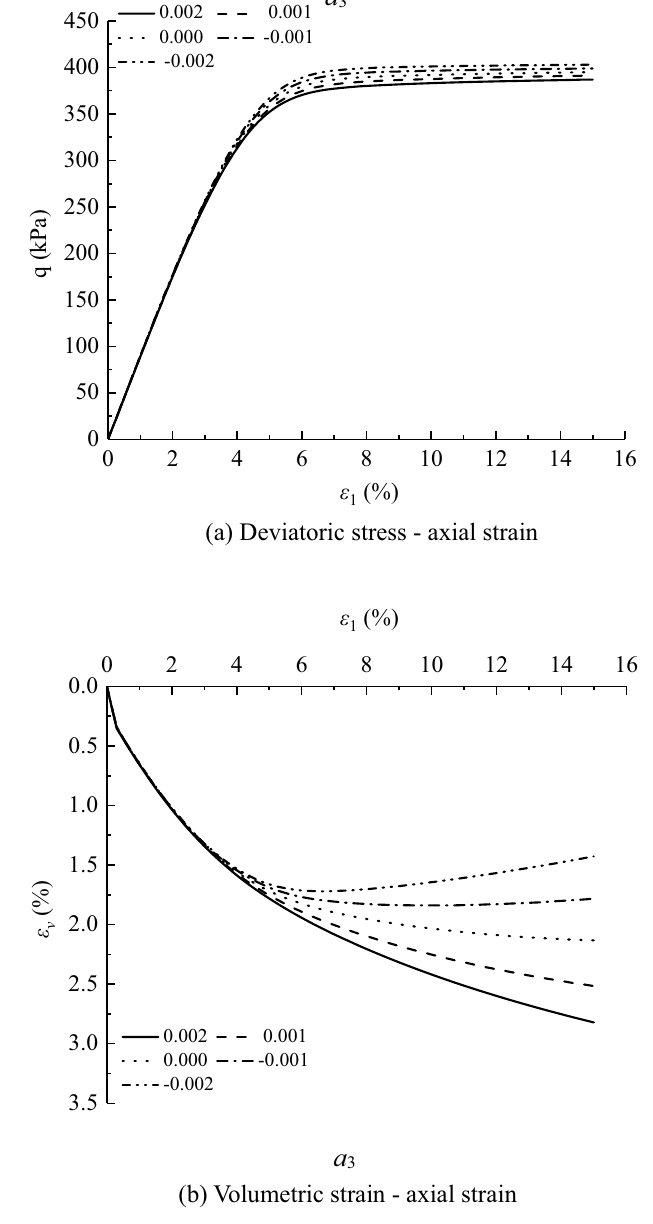
Figure 14. Sensitivity analysis of simulation results with varying a 3